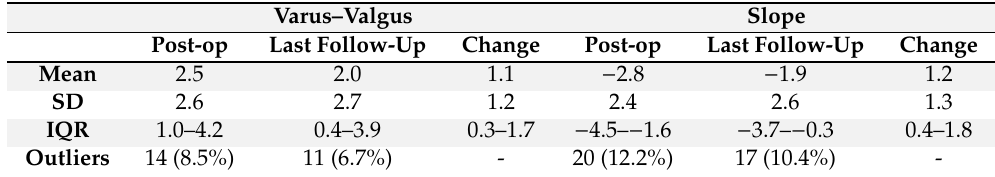
Table 2. Tibial implant position angles (values in ◦ ). Positive values indicate varus and posterior downslope. Negative values indicate valgus and anterior downslope. n = 164.